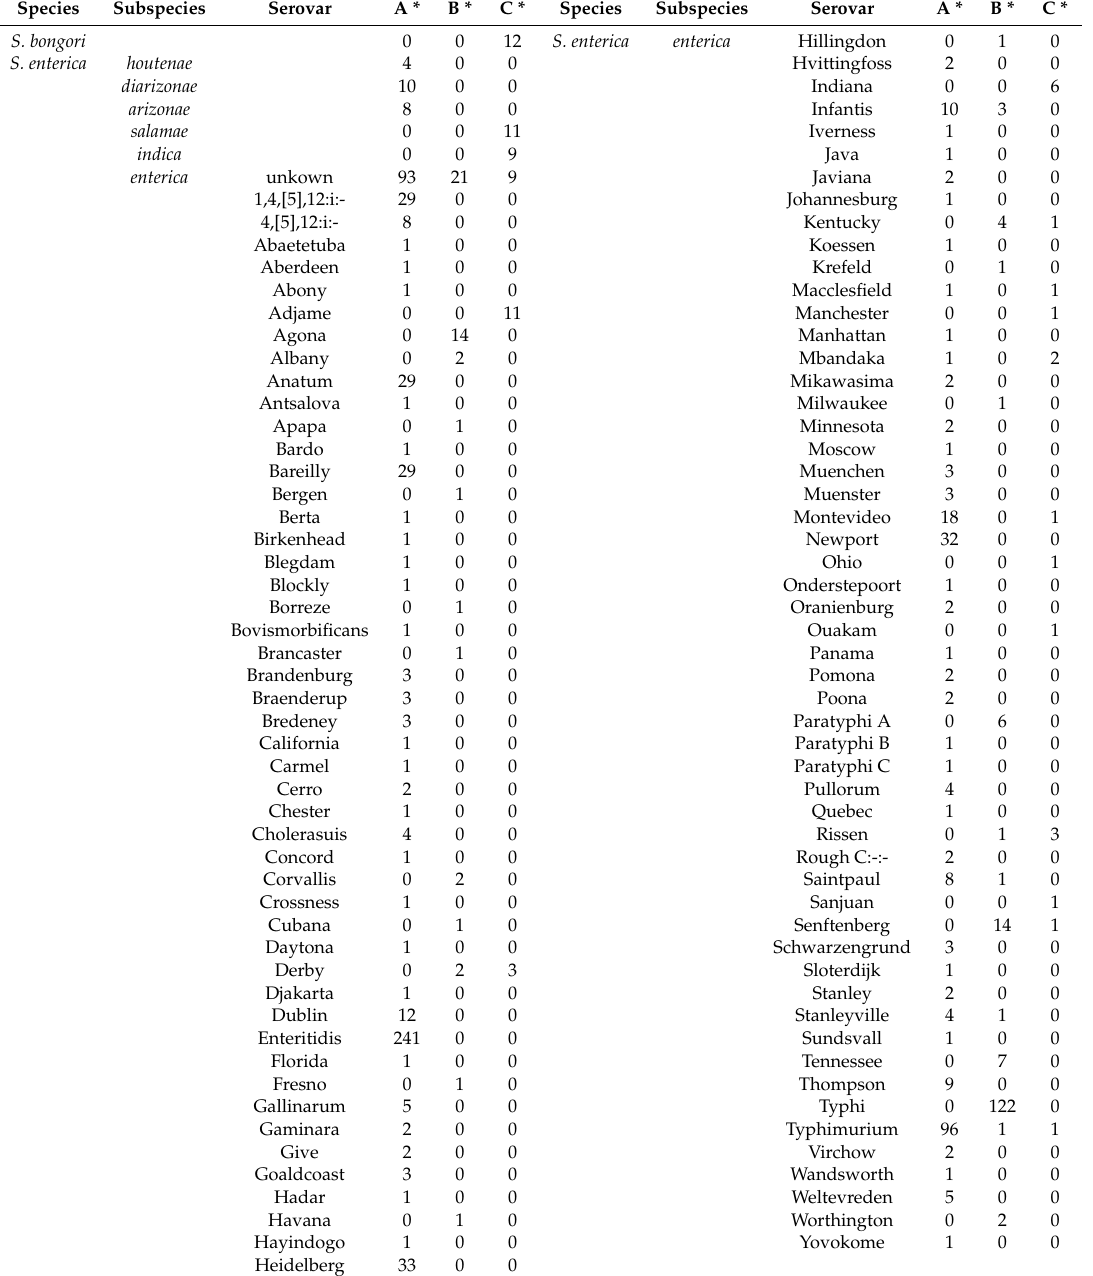
Table 1. Number of complete genome sequences of Salmonella isolates belonging to di ff erent species, subspecies and serovars with genes for itaconate degradation (Column A), for bacteriocin immunity (Column B) or neither (Column C). A total of 1063 Salmonella genomes was searched using Blast N.